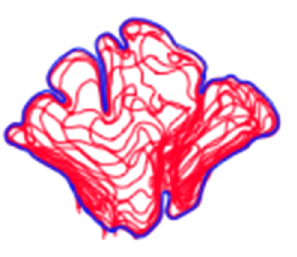
Figure 1. Example of CT image slices from a study individual with the frontal sinuses traced in red in Adobe Photoshop.